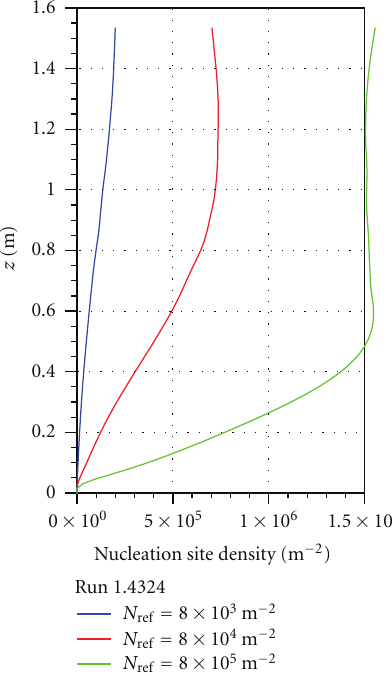
Figure 2: Cross-sectionally averaged gas fraction for di ff erent values d ref (8). Figure 3: Nucleation site density N (9).